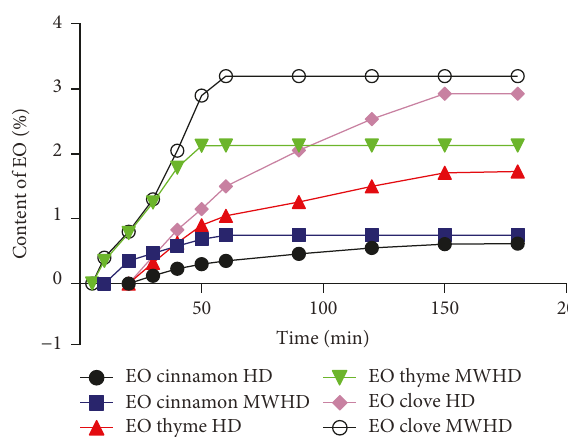
Figure 1: Kinetic extraction of essential oils (EO) obtained by the method of steam distillation (HD) and microwave-assisted hydrodistillation